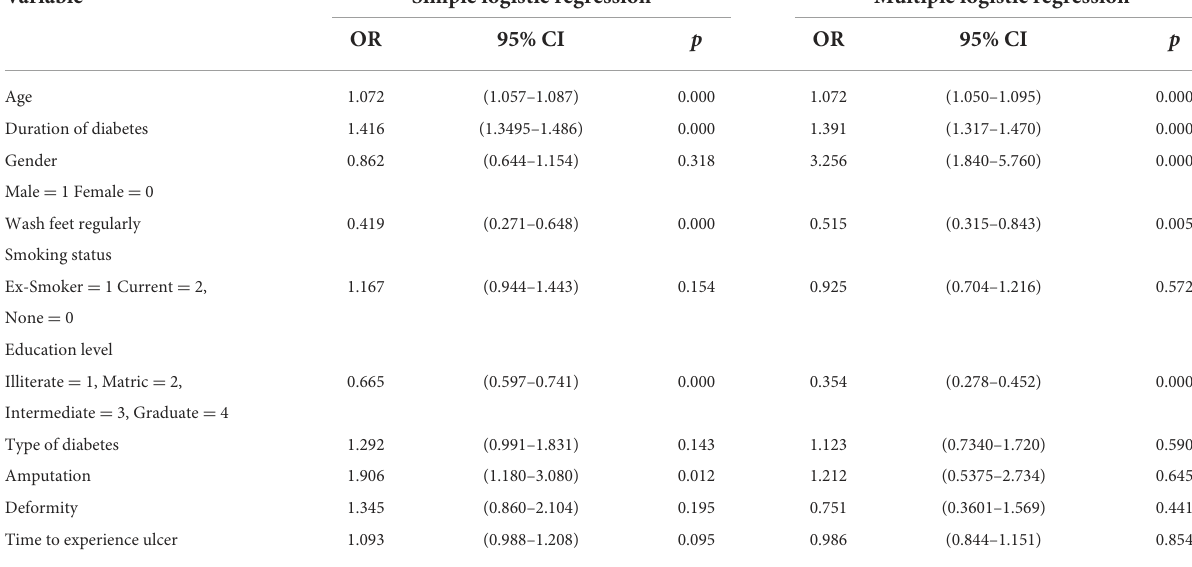
TABLE 3 Odds Ratios, confidence interval, chi-square, and p -value of the variables under